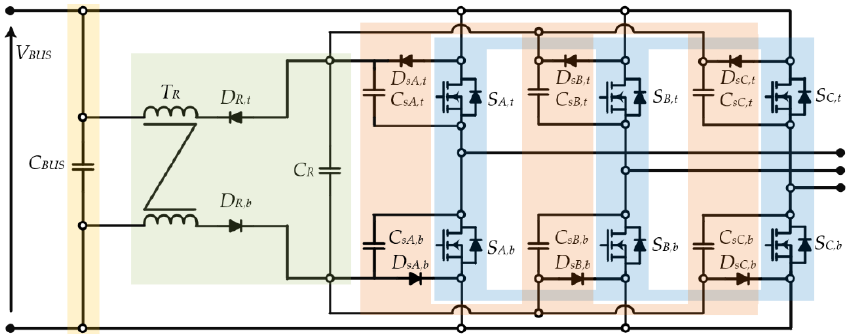
Figure 4. Voltage waveform across the inverter and the motor during the turn-on.